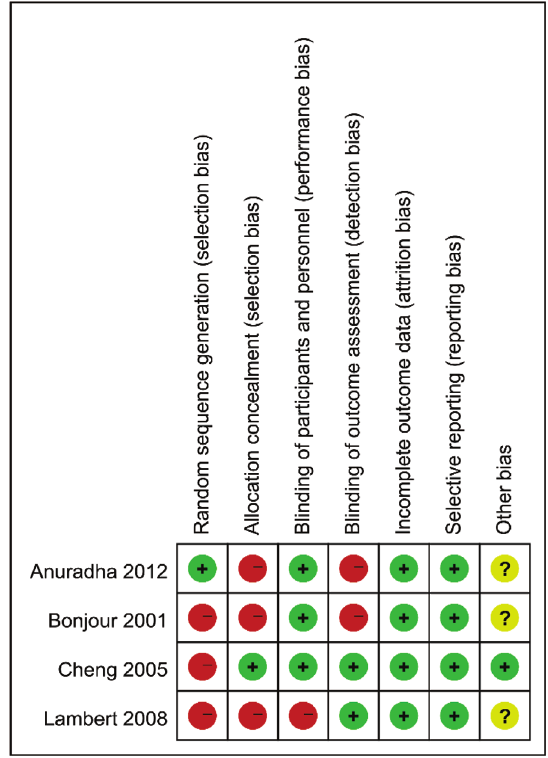
Figure 2. Risk bias evaluation